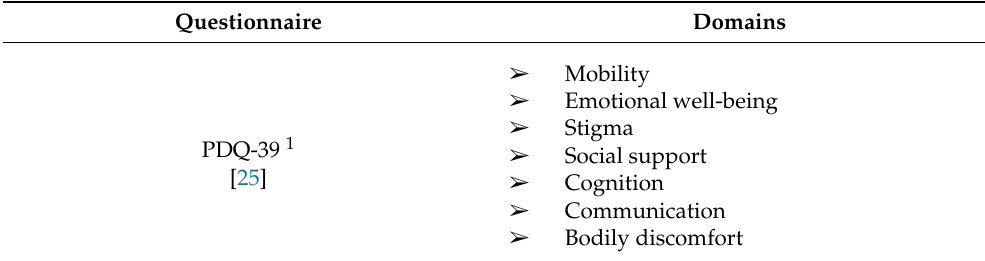
Table 2. Key instrument for measuring quality of life in Parkinson’s